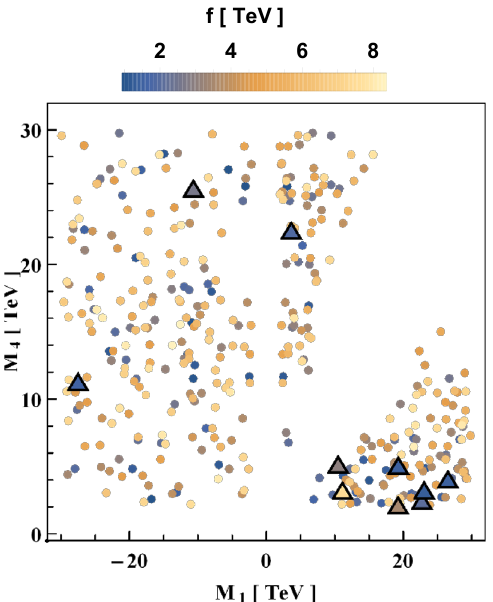
Figure 18 . High scale scan of the MCHM 5 parameter space, including the benchmark points of ta- ble 7 represented by triangles and the points satisfying the constraint in eq. 5.1. The compositeness scale f is color